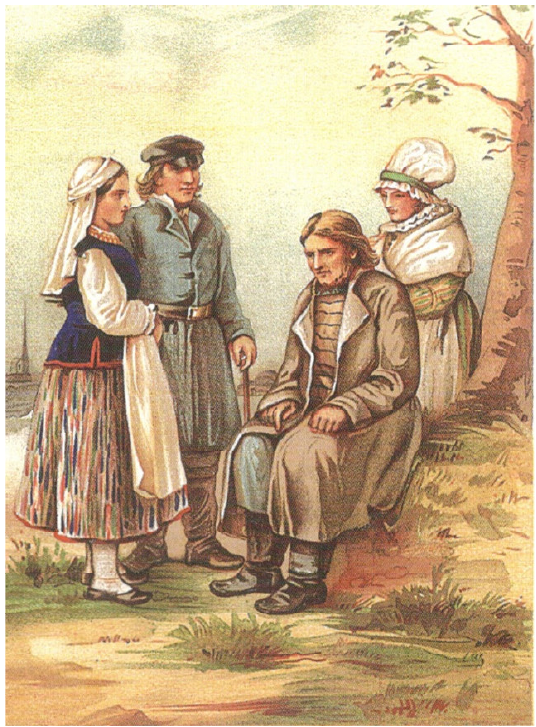
Figure 2. Lithuanians and Latvians [50].